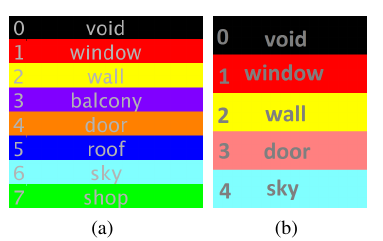
Table 1. Labeling results of the classification stage on Figure 2. Label sets and colors for (a) ECP dataset (b) Graz dataset